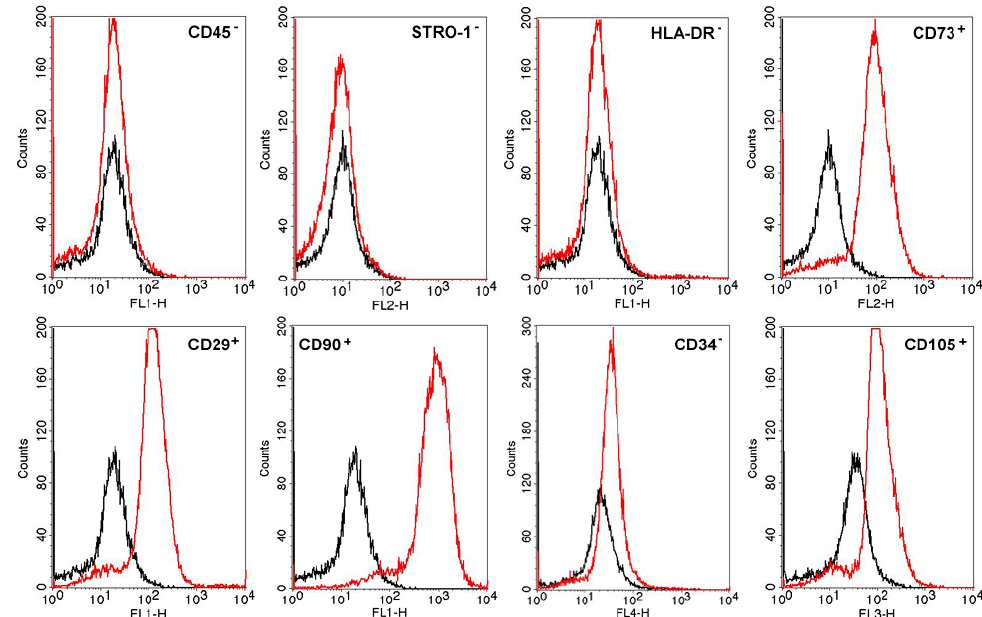
Figure 1. Results of flow cytometry analysis of the AT-MSCs. The cells were expanded to the fourth passage and analyzed by flow cytometry (10,000 cells were analyzed). Black histogram represents the expression of each molecule of IgG (negative control) and red histogram shows different markers investigated in the cell membrane of AT-MSCs.